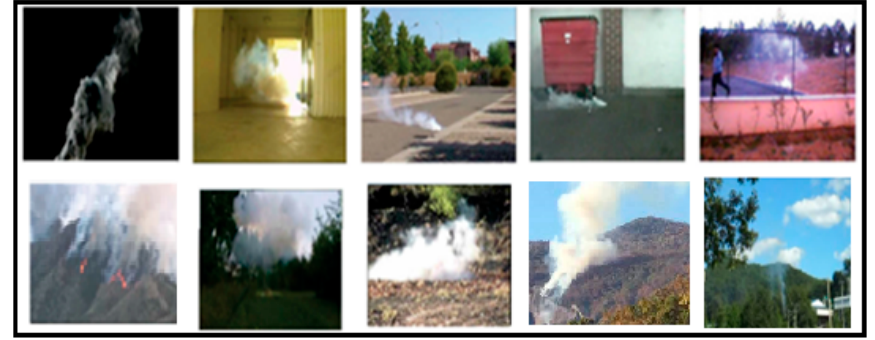
Figure 1. The environments and samples of smoke video database: examples of frames containing smoke.